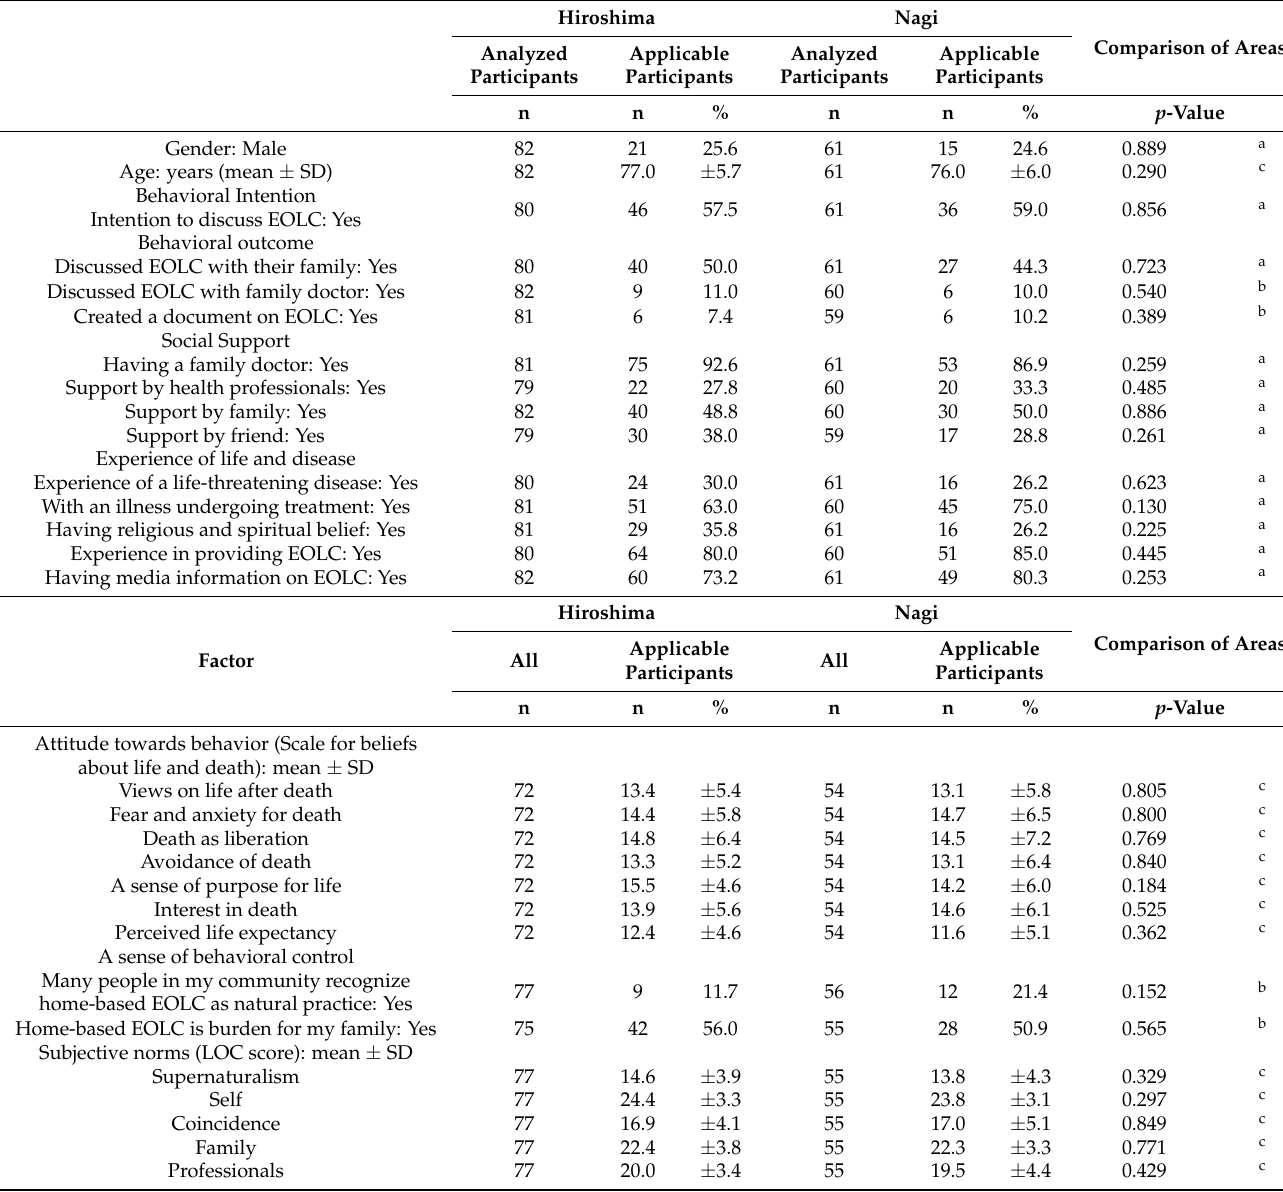
Table 2. Comparisons between Hiroshima and